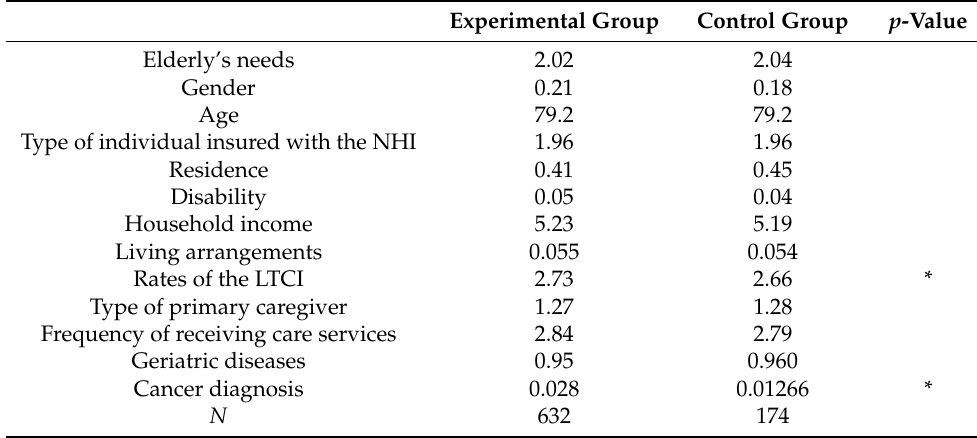
Figure 1. Before and after propensity score matching (PSM). Table 1. General characteristics of the experimental and control groups after PSM. Experimental